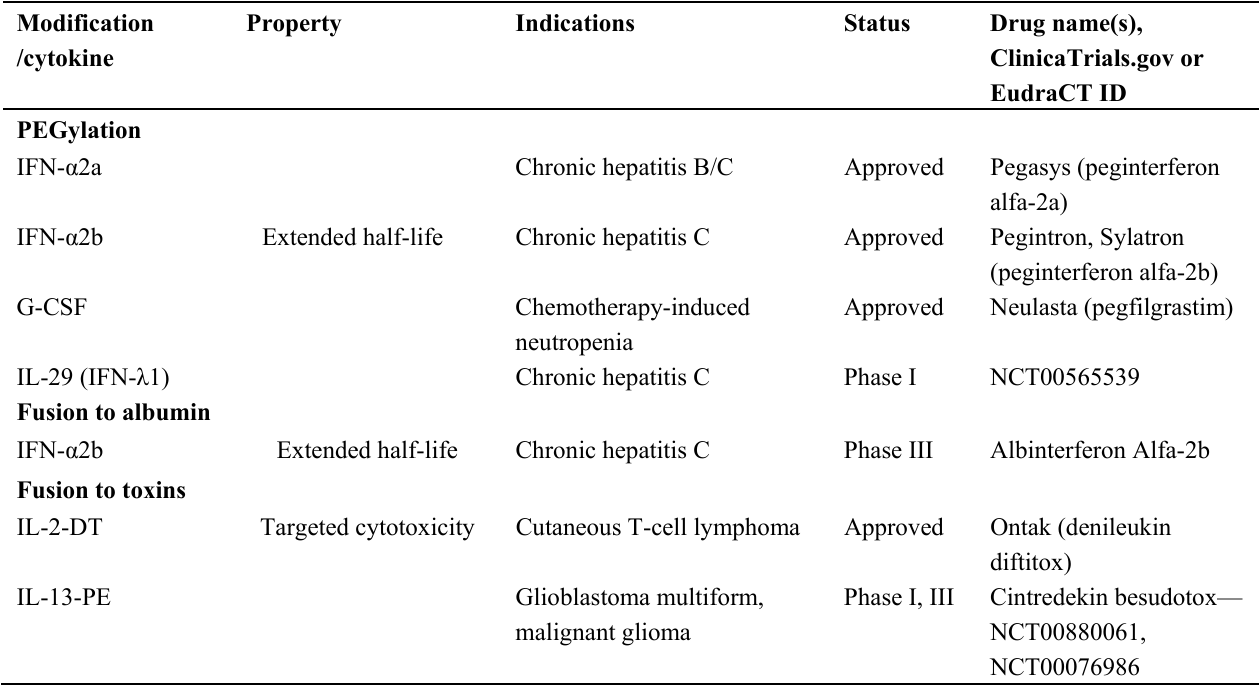
Table 2. Engineered cytokines approved for clinical use or undergoing clinical